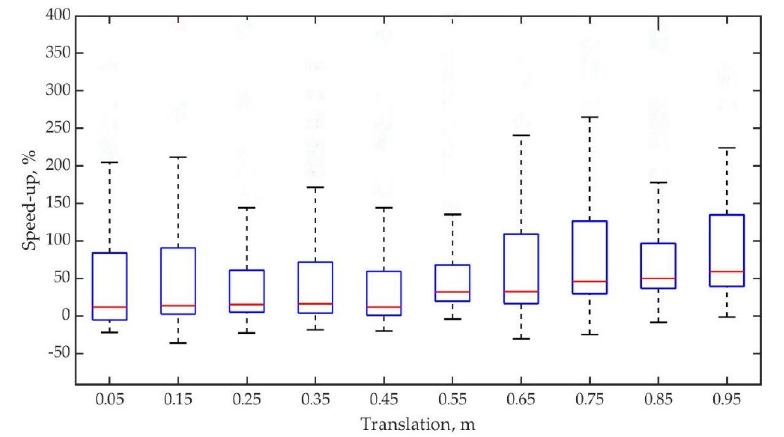
Figure 12. Box-plot of relative intensity assisted ICP speed-up versus random translation distance for dataset.